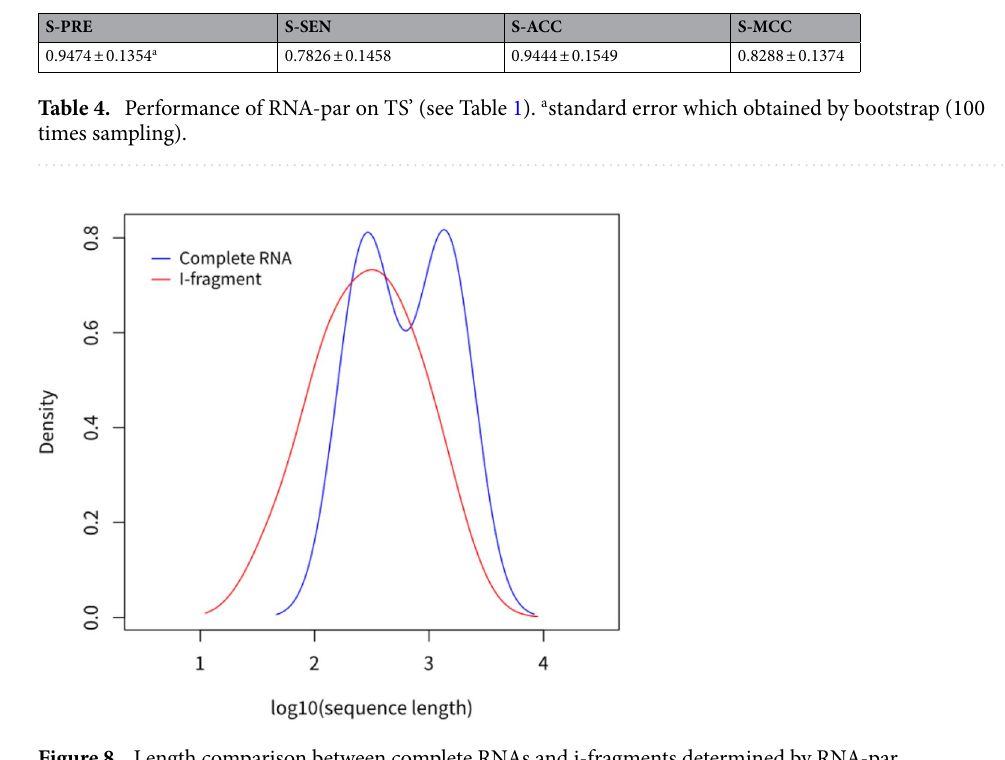
Figure 8. Length comparison between complete RNAs and i-fragments determined by